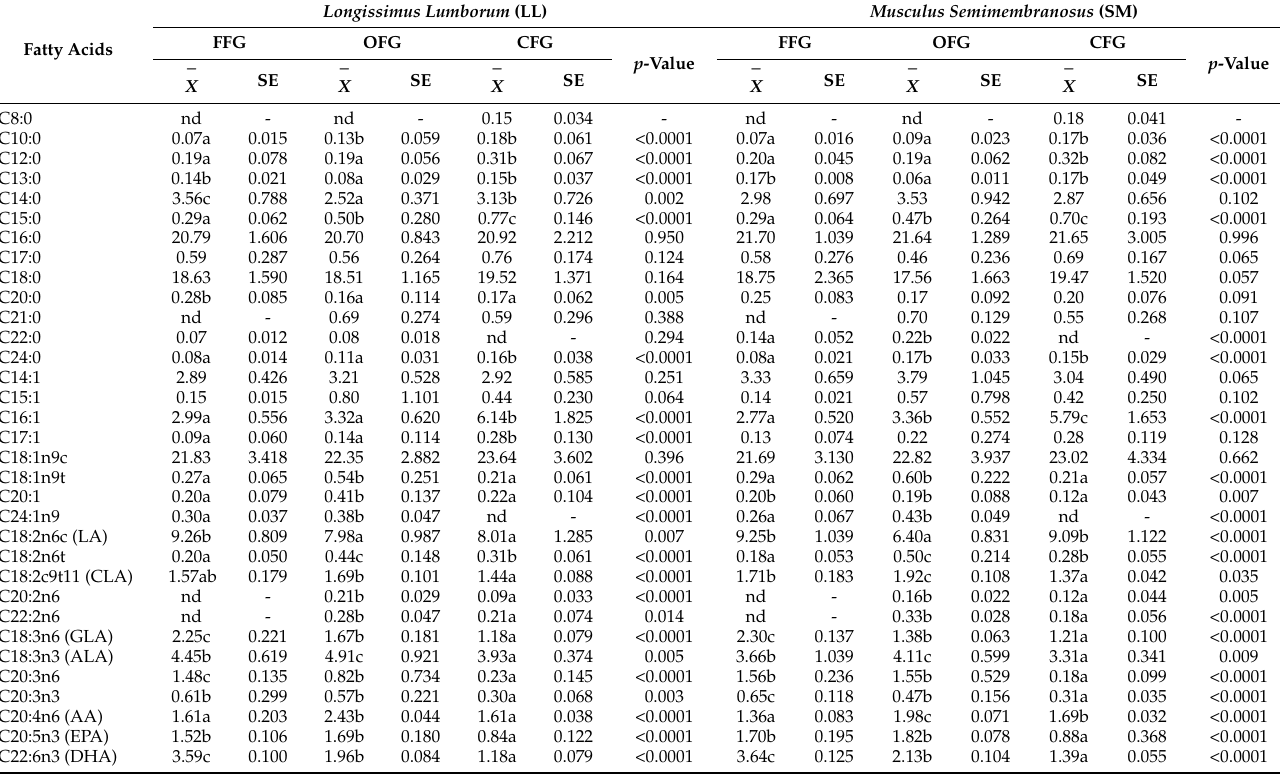
Table 3. Fatty acid profile (g/100 g FA) in red deer meat sampled from the three feeding